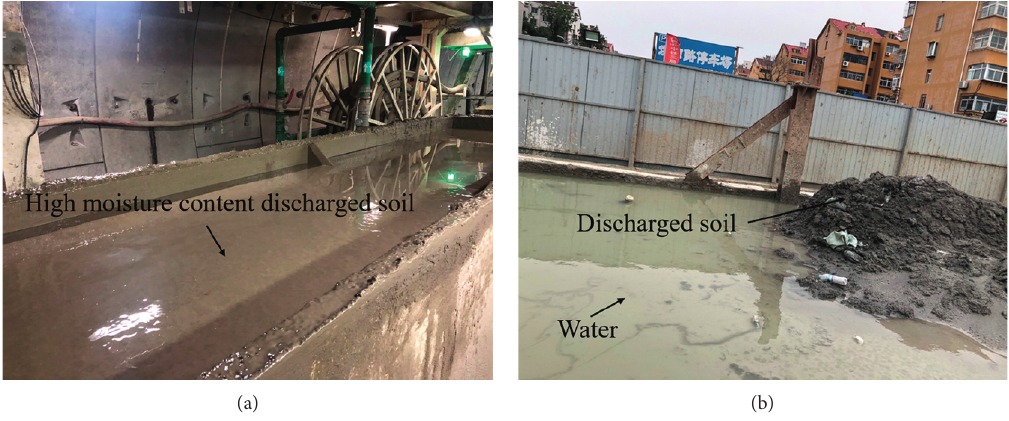
Figure 6: Discharged soil at the construction site.